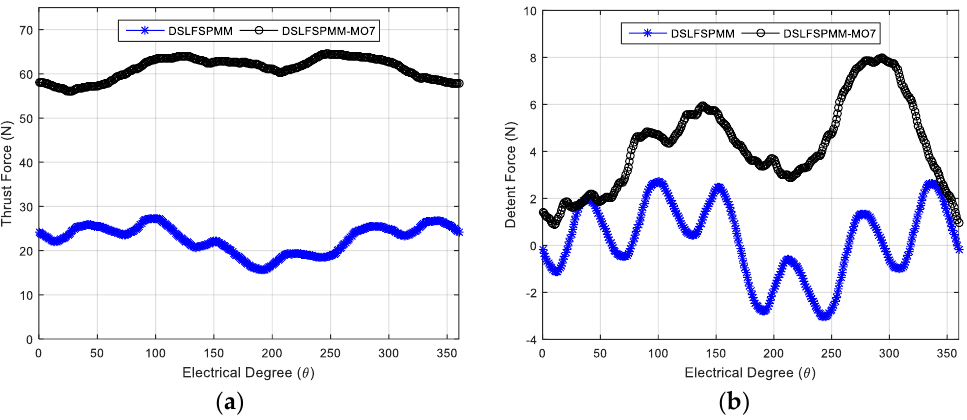
Figure 22. Comparison of DSLFSPMM and DSLFSPMM-MO7: ( a ) Thrust force; ( b ) No-load detent force.